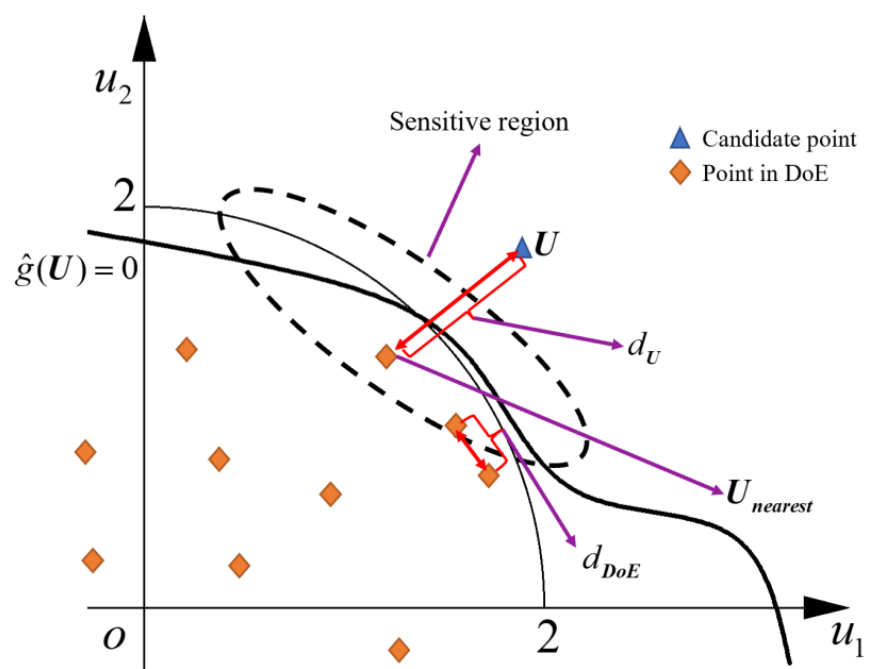
Figure 1. Illustration of the distance control.